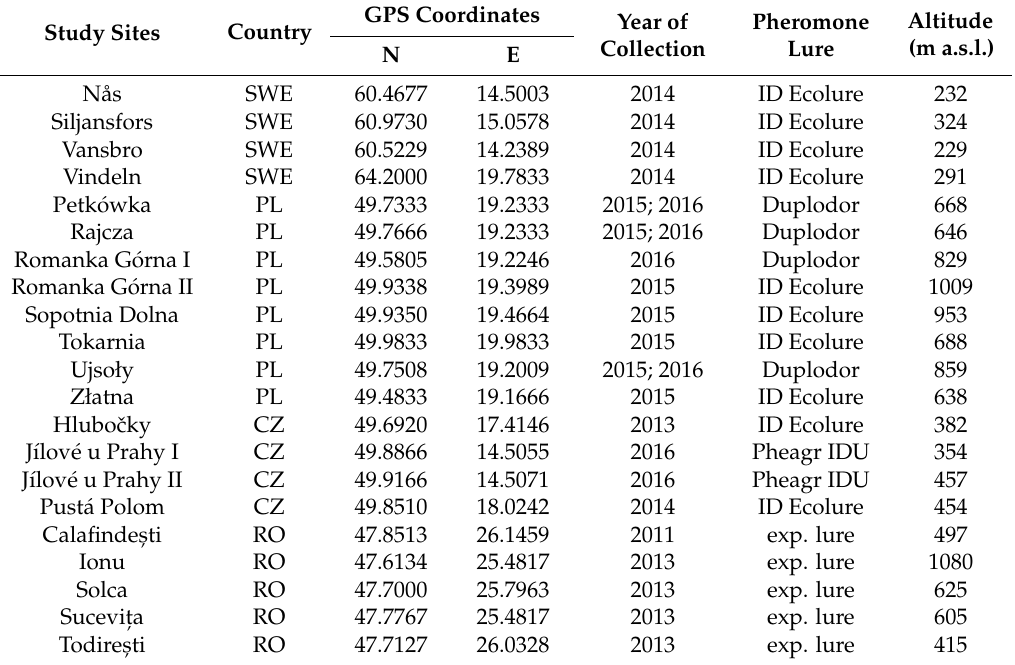
Table 1. Background information on the study sites where I. duplicatus specimens were collected and assessed for pathogen infection. Country of origin (Country): Sweden (SWE), Poland (PL), Czech Republic (CZ), Romania (RO). In traps were used different pheromone lures: ID Ecolure, Duplodor, Pheagr IDU and in Romania the experimental lure (exp. lure)